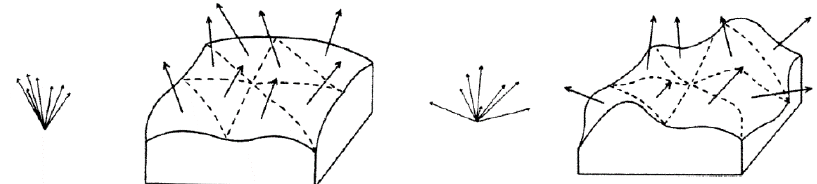
Figure 2. Schematic block diagrams showing how the surface roughness of the terrain can be reflected by the unit direction vector of each pixel in a digital elevation model (DEM). If the ground surface is smooth, the unit direction vectors are aggregative. If the ground surface is rough, the unit direction vectors are dispersed.